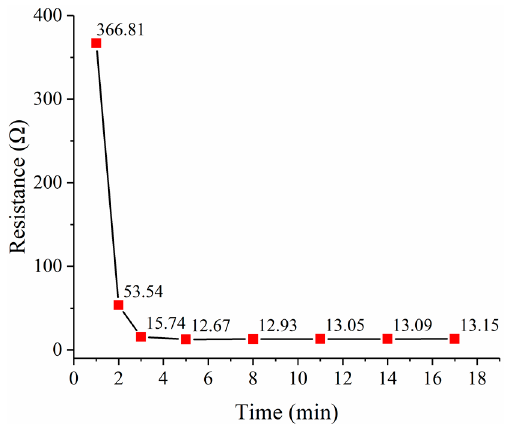
Figure 9. The resistance of the PEDOT/PSS film versus the heat drying time.